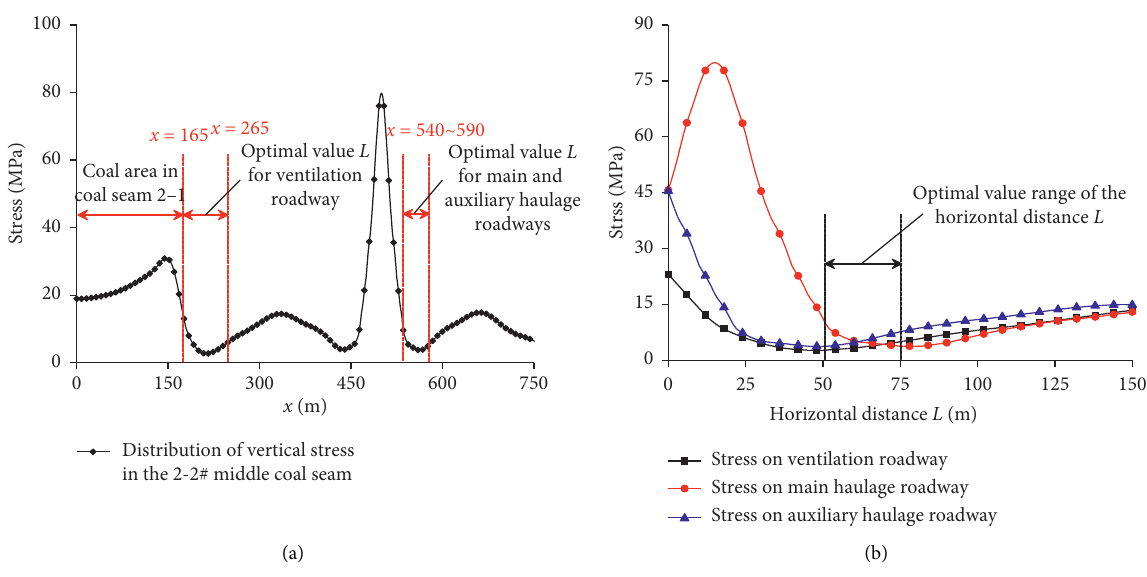
Figure 6: Quantitative analysis of the horizontal distance L most conducive to roadway excavation. (a) The distribution of vertical stress on the 2-2# middle coal seam. (b) The optimal values of L .